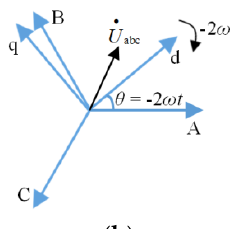
where ω is the fundamental frequency.